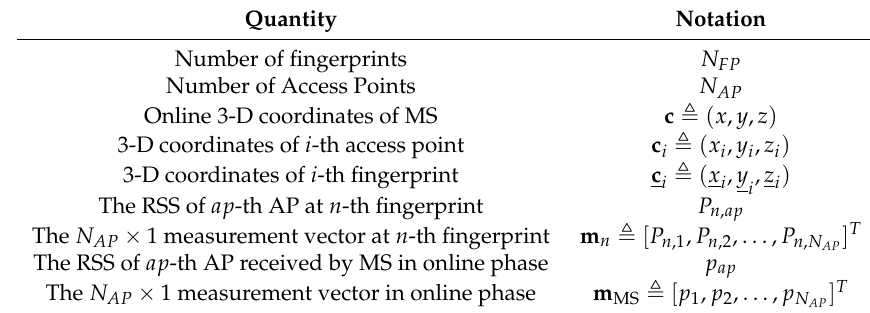
Table 1. Most important positioning-related notations used in this paper. AP: Access point; MS: Mobile station; RSS: Received signal